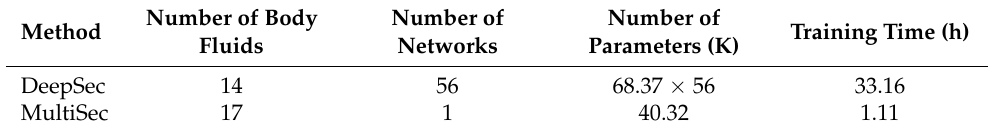
Table 4. Comparison of MultiSec and DeepSec on computational